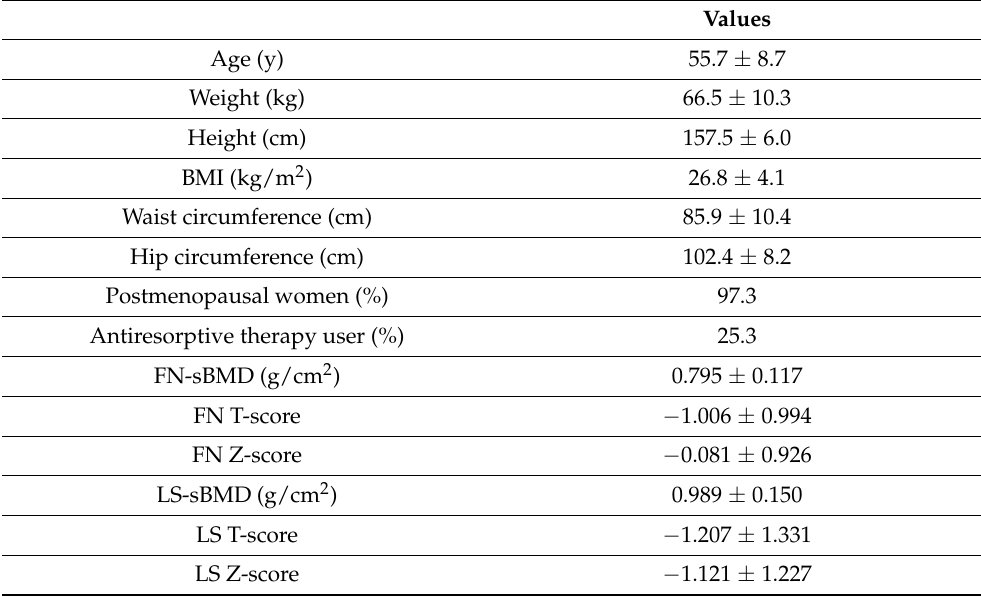
Table 2. Anthropometric and bone characteristics of the cohort studied. Values are mean ± SD or percentage. N = 1001 women 1